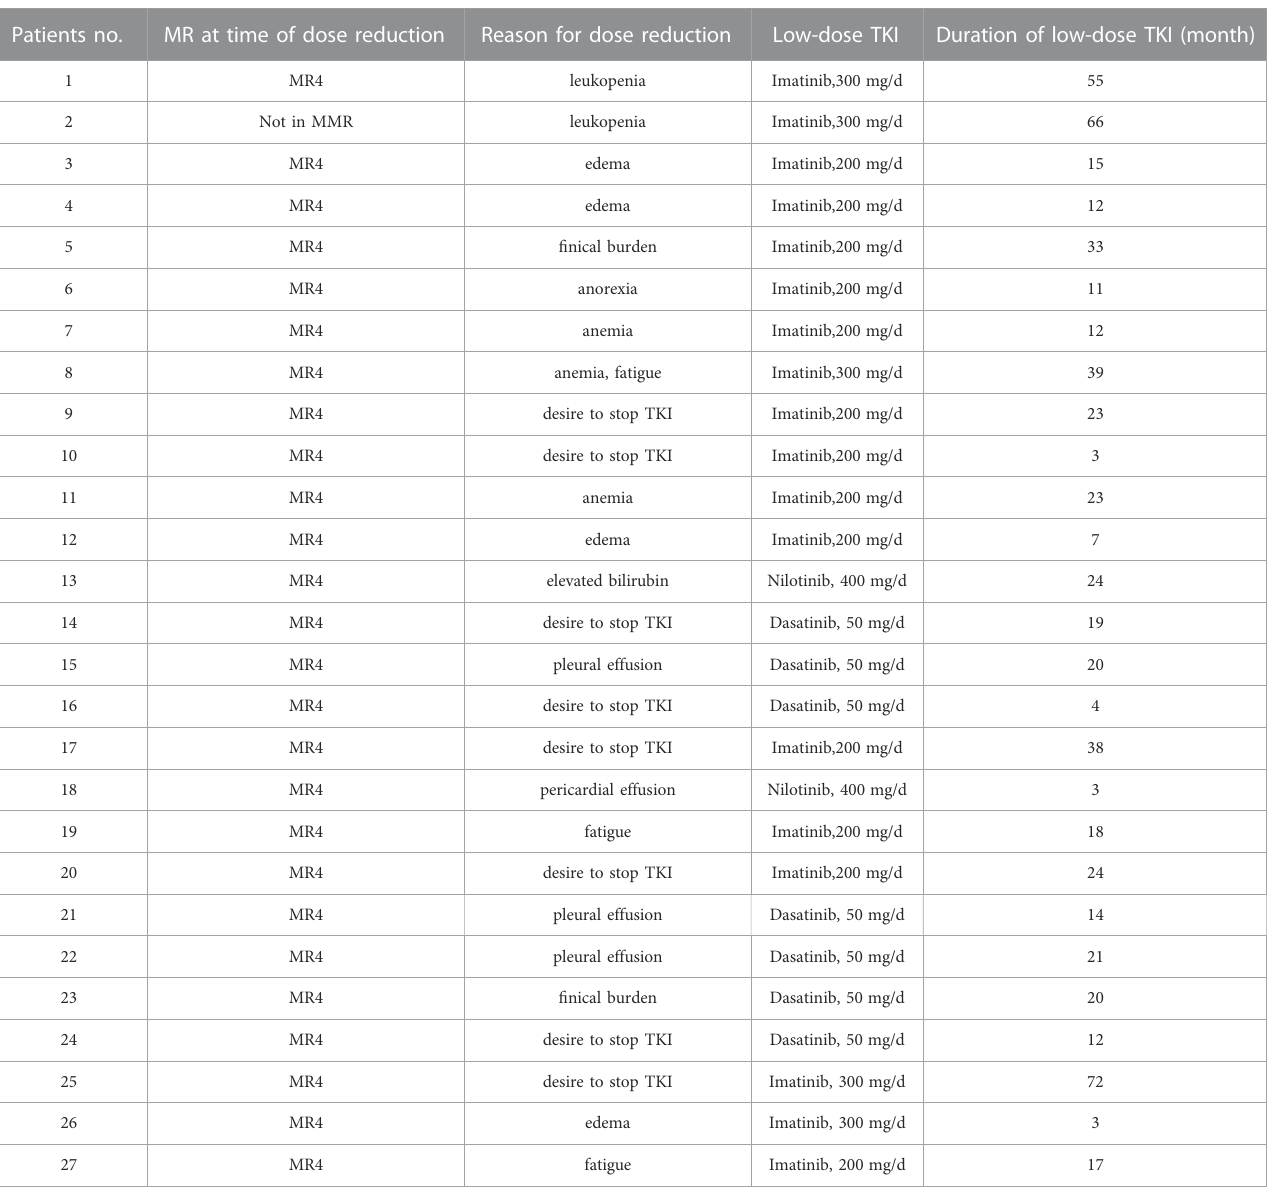
TABLE 2 Reasons and dose for patients with dose reduction. Patients